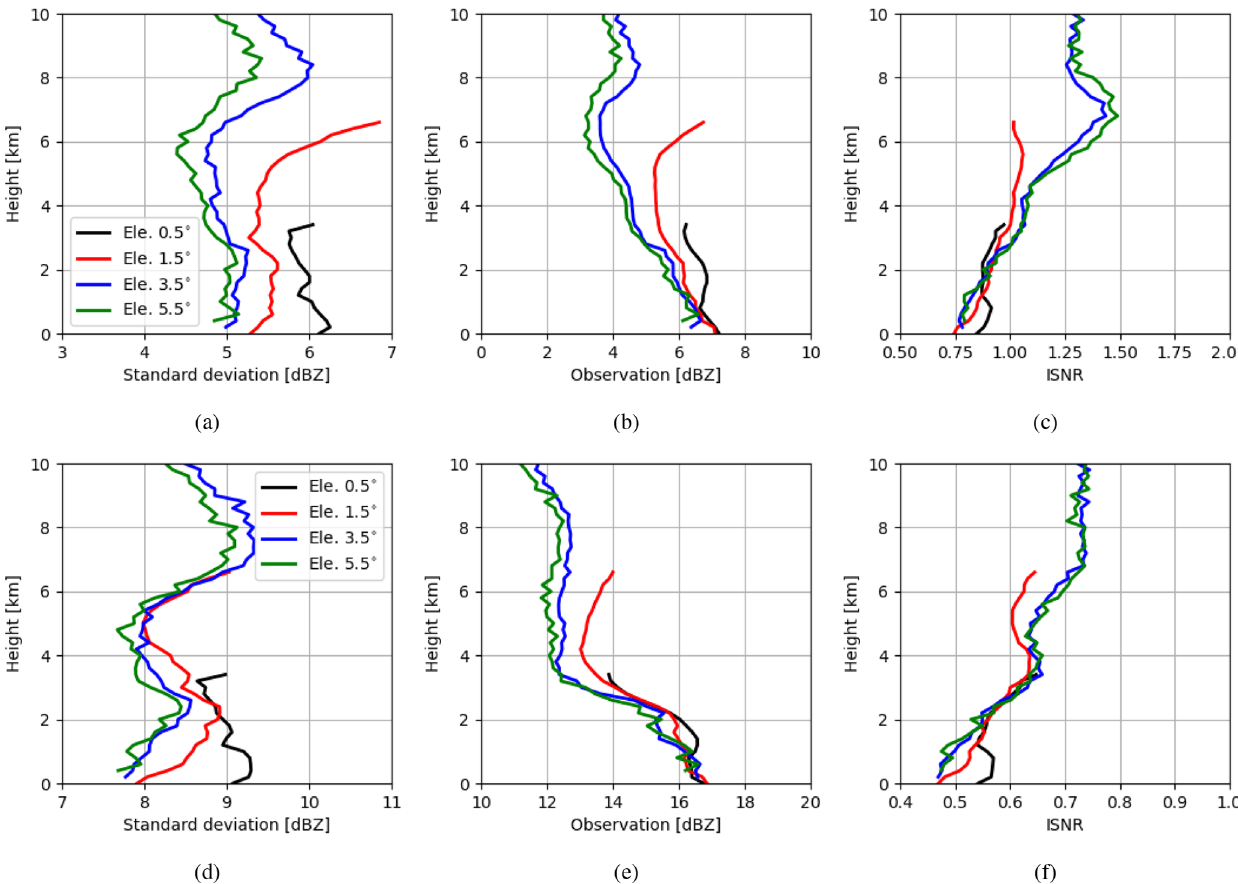
Figure 9. (a) Vertical profiles of the estimated standard deviations of the OE for reflectivity data ≥ 0dBZ at elevations of 0 . 5, 1 . 5, 3 . 5 and 5 . 5 ◦ . (b) Vertical profiles of observed reflectivity data ≥ 0dBZ, averaged over all samples; (c) ISNR, i.e., standard deviations in panel (a) are divided by observation data in panel (b) for each elevation, respectively; (d–f) for reflectivity data ≥ 5dBZ. For each elevation, the samples are binned every 200m in the vertical. Since model states are not updated above 10km, standard deviations continuously increase (see Waller et al., 2019). Here we show results only up to